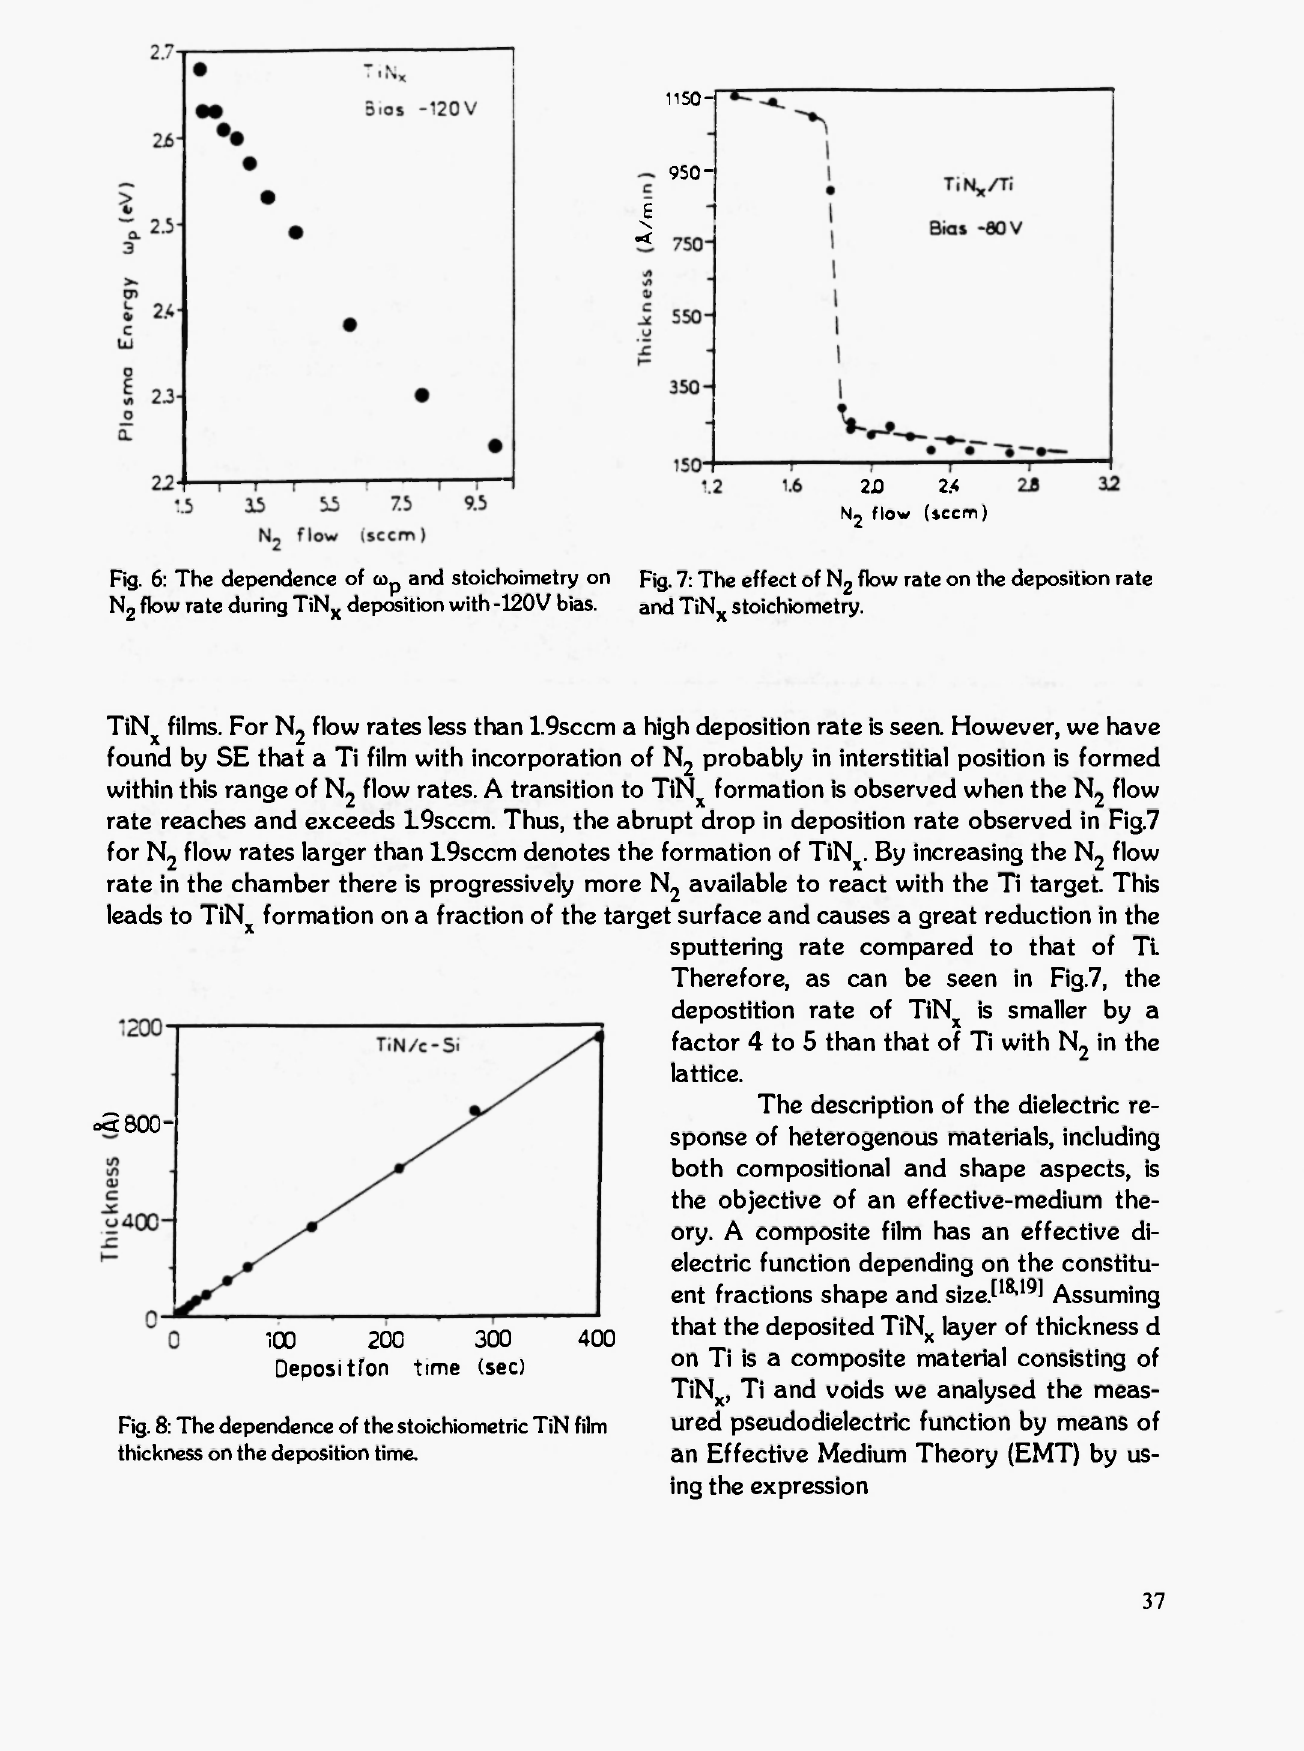
Fig. 8: The dependence of the stoichiometric TiN film thickness on the deposition